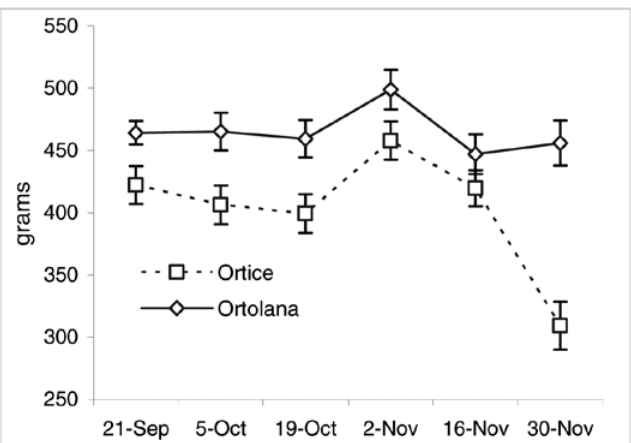
Fig. 2 - Evolution of olive detachment force during maturation (mean ± standard error). Table 1 - Characteristics of trees and fruit at harvest, machine efficiency and work productivity (mean ± standard